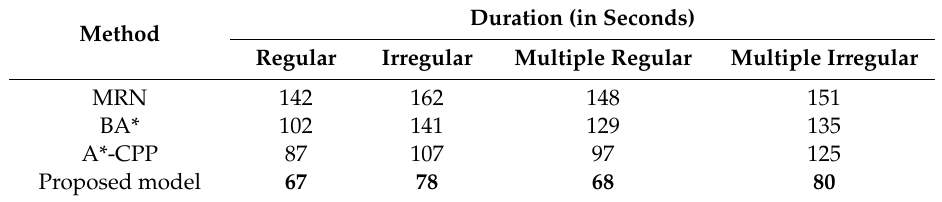
Table 5. A comparative analysis of the duration time to visit the operational environment .